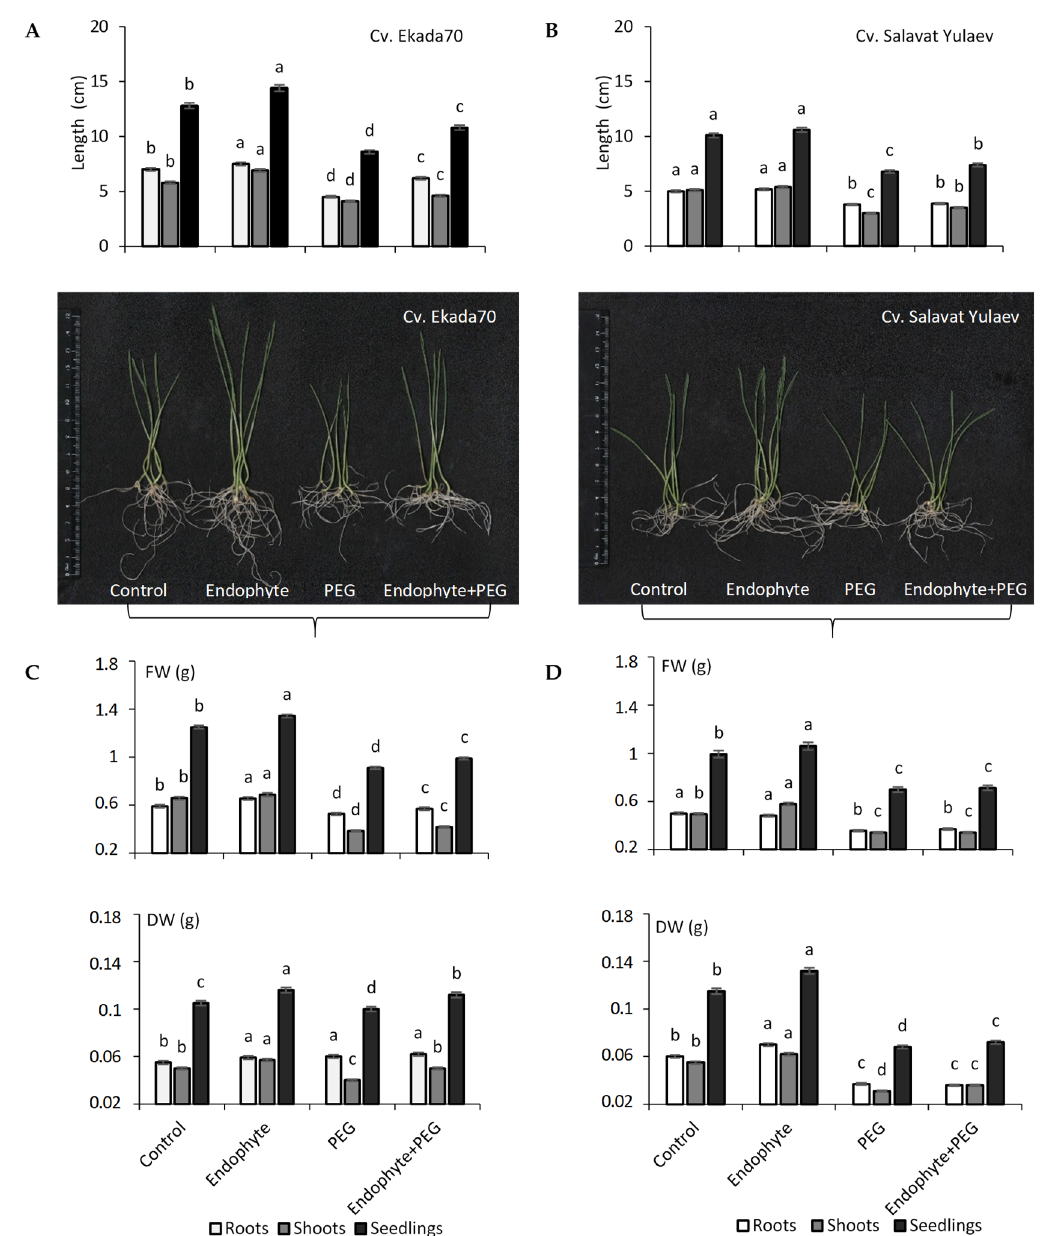
Figure 3. Effect of endophytic B. subtilis 10-4 (endophyte) on the elongation of six-day old seedlings (length of the roots, shoots, and their visual appearance), fresh (FW), and dry biomass (DW) accumulation of wheat of cv. Ekada70 ( A , C ) and cv. Salavat Yulaev ( B , D ) under normal and drought (12% PEG–6000) conditions. The bars are the means of three repetitions ± SEM (n = 100, three replicates). FW, fresh weight; DW, dry weight. Different letters indicate a significant difference between the means at the probability level of p < 0.05.